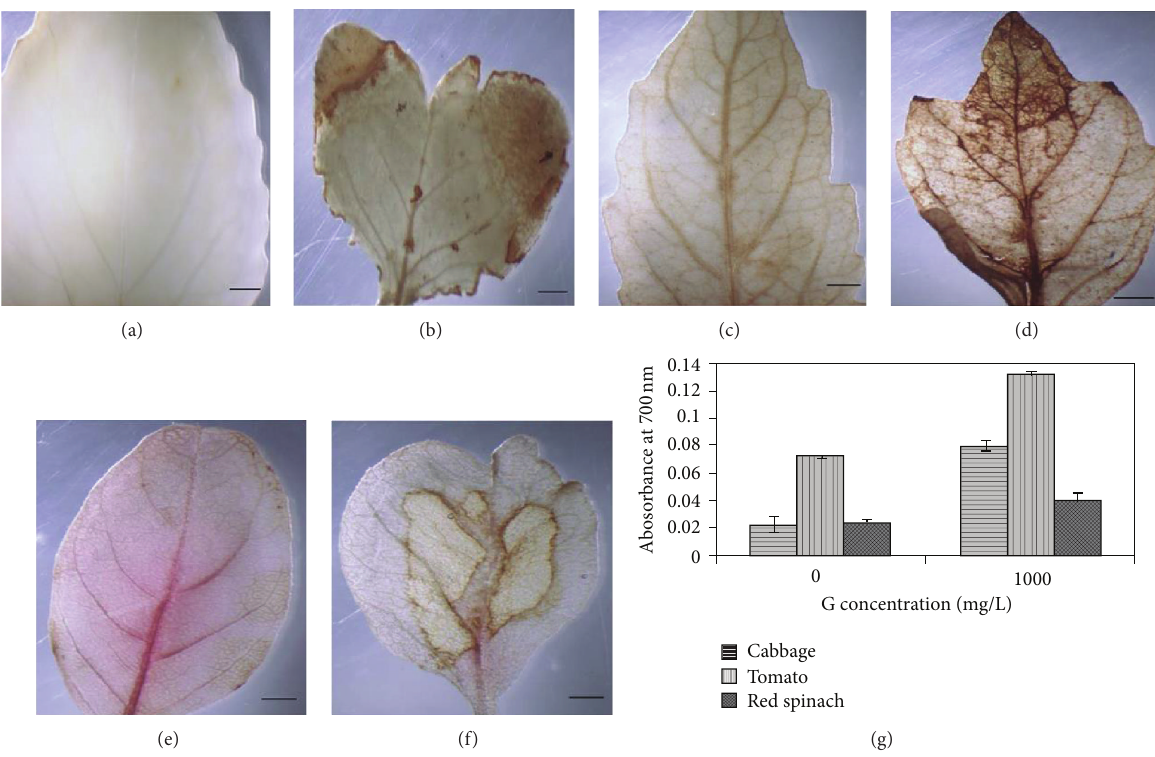
Figure 6: Effects of graphene (G) on accumulation of H 2 O 2 in leaves tested by means of the ROS-sensitive dye DAB of red spinach, cabbage, and tomato seedlings. 21 days leaves treated with or without 1000mgL −1 graphene were utilized for all measurements. (a), (c), and (e) are cabbage, tomato, and red spinach leaves without graphene, respectively. (b), (d), and (f) are cabbage, tomato, and red spinach leaves with graphene (1000mgL −1 ), respectively. The brown staining shows the formation of a brown polymerization product when H 2 O 2 reacts with DAB. (g) Effect of graphene (1000 mgL −1 ) on the accumulation of H 2 O 2 in treated leaves as measured utilizing DAB [28].